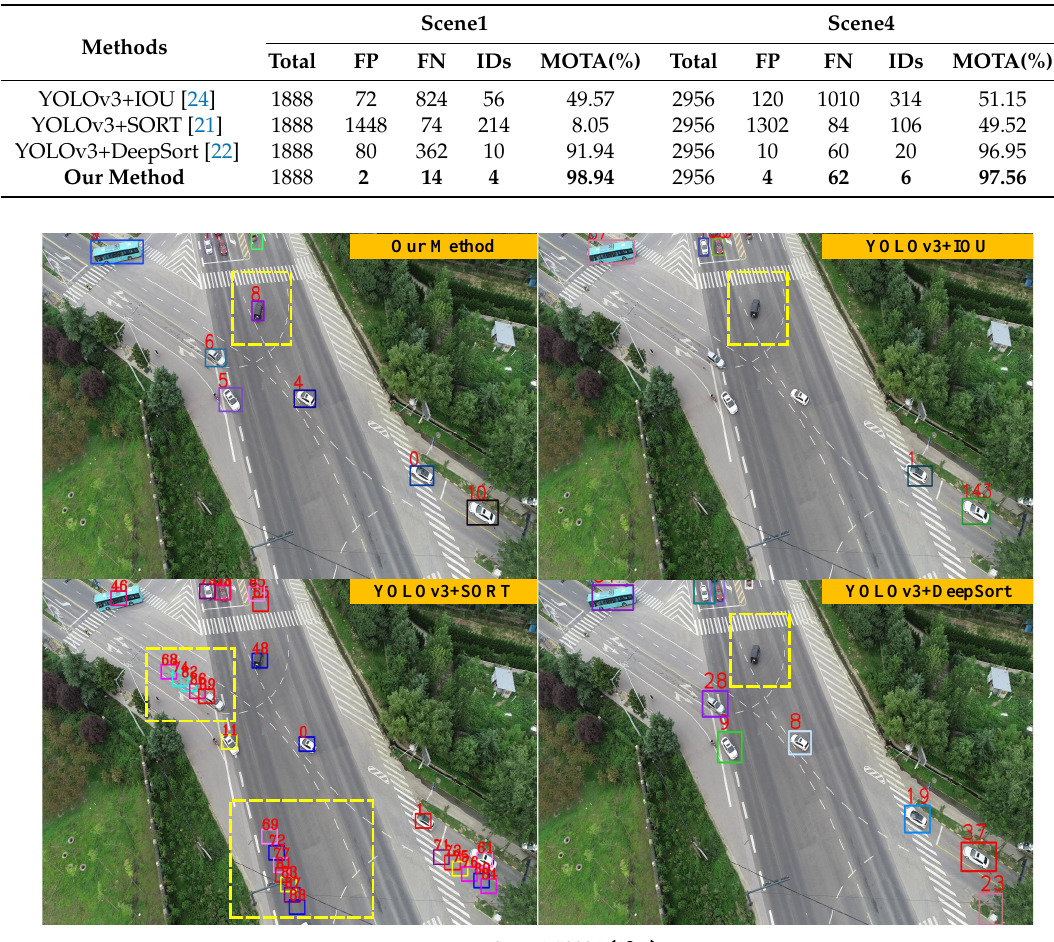
Table 1. Tracking performance parameters of four tracking methods.